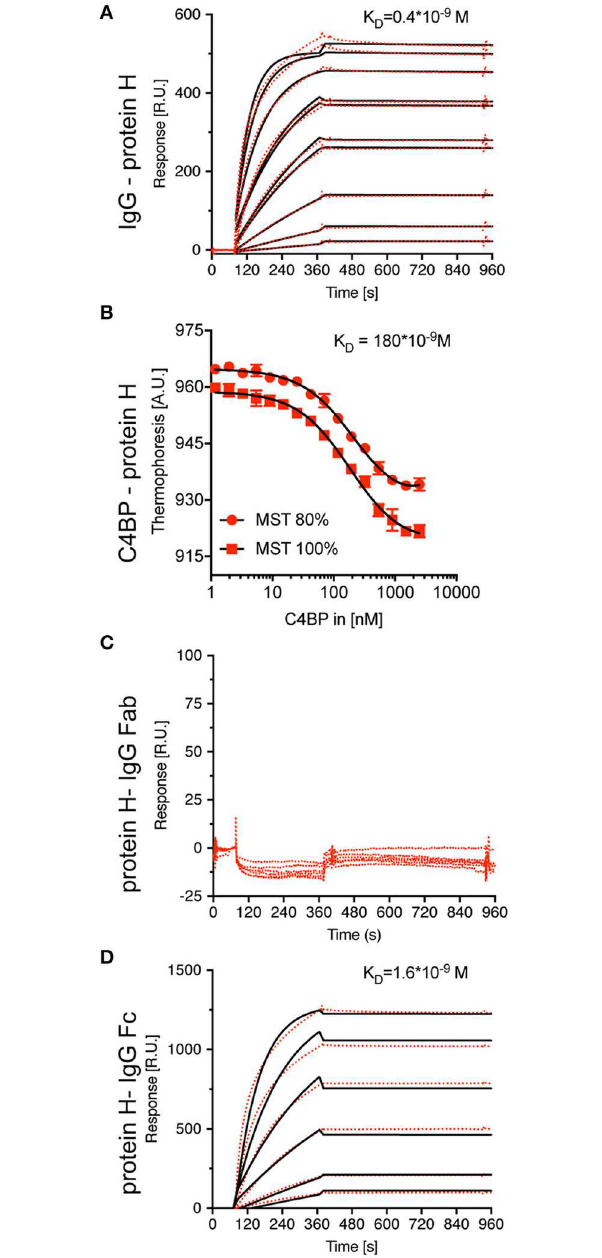
FIGURE 3 | Protein H binds C4BP and IgG (-Fc) with high affinity, but not IgG-Fab. To define equilibrium affinity constants for IgG-Protein H (A) and C4BP-Protein H (B) interaction, surface plasmon resonance and thermophoresis analysis were performed, respectively. Surface plasmon resonance analysis revealed that Protein H does not interact with IgG-Fab (C) but binds IgG-Fc strongly (D) . Red dots represent individual measurements, black lines are corresponding